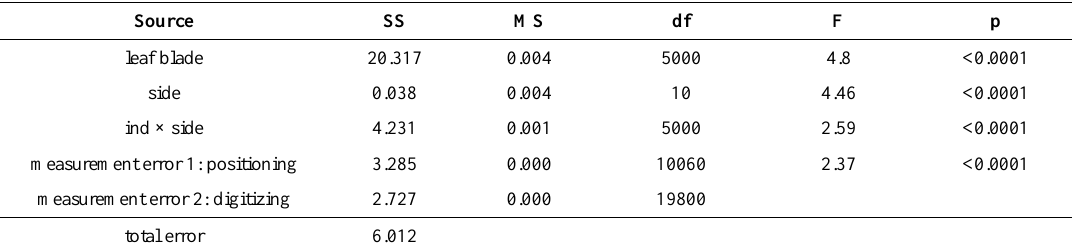
Table 1. Measurement error for leaf